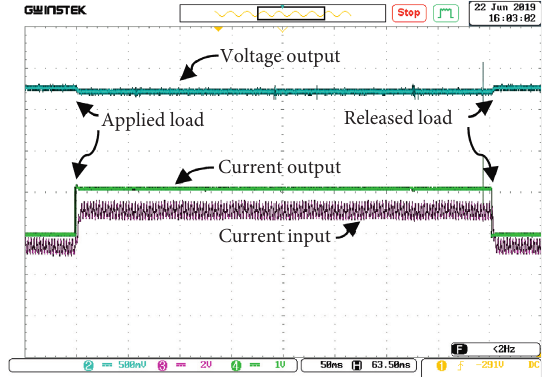
Figure 18: Result of inductor current of the 4 phases of the four- phase interleaved boost converter circuit.